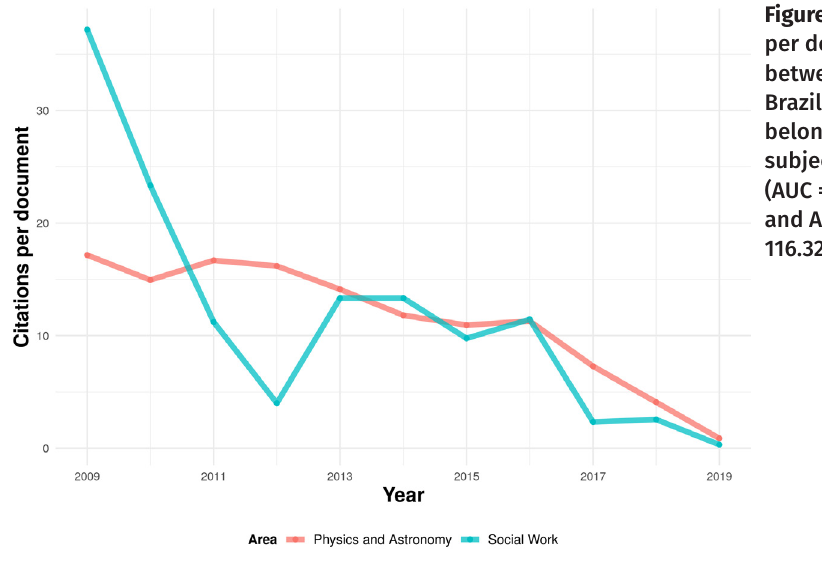
Figure 9. Number of